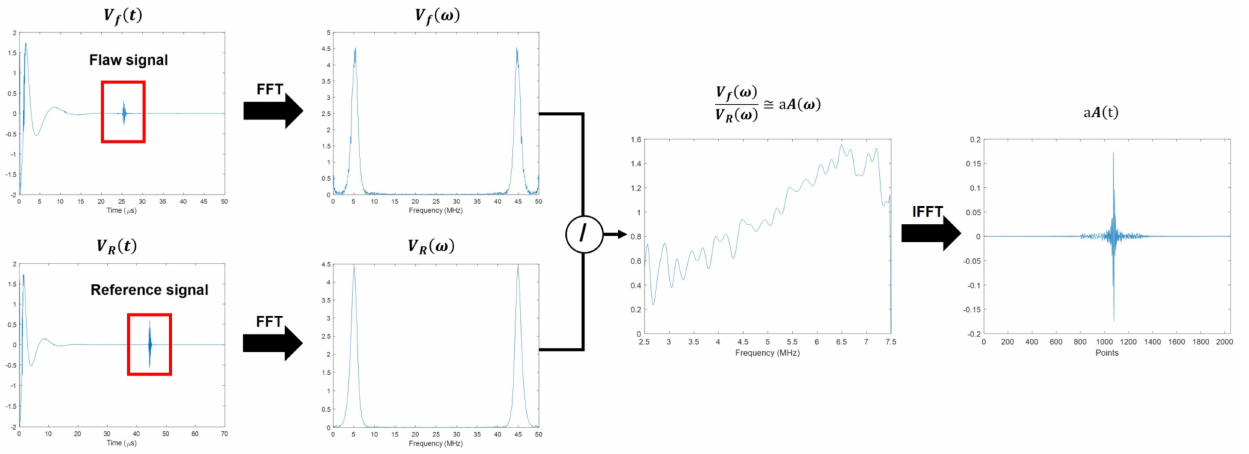
Figure 7. Flow diagram of the system invariant